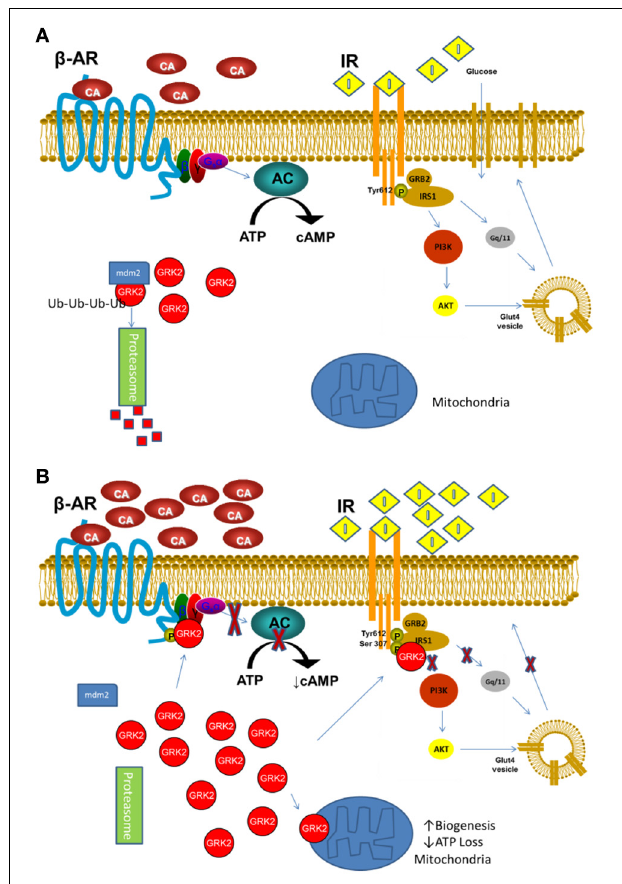
FIGURE 1 | (A) In basal or low stimulation conditions GRK2 is mostly cytosolic and its level are tightly regulated by mdm2 ubiquitination and degradation through the Proteasome. (B) Following acute or excessive stimulation by catecholamines or Insulin or hypoxia, GRK2 detaches from mdm2 and quickly accumulates in the cell, moving to membranes where desensitizes β -AR and IR. Moreover, it can translocates to the mitochondria, reducing ATP loss and inducing mitochondria biogenesis ( β -AR, β Adrenergic Receptor; IR, Insulin Receptor; CA, Catecholamine; I,